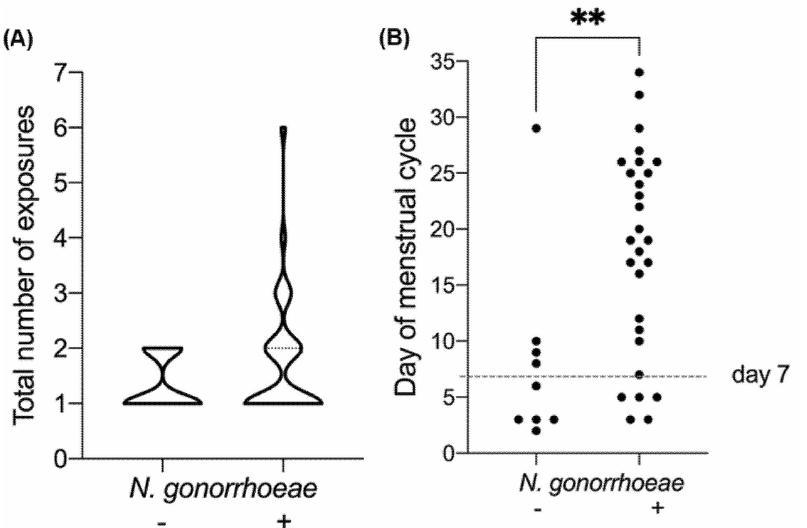
Figure 2. Neisseria gonorrhoeae infection in women exposed to men with gonococcal urethritis. Impact of ( A ) number of exposures and ( B ) menstrual cycle in N. gonorrhoeae culture-negative women ( N. gonorrhoeae -) and culture positive ( N. gonorrhoeae +) women. Infection was associated with a high number of total exposures (>2 and up to 6) ( A ). Uninfected women were mostly exposed during the follicular phase (1–11 days). The most recent exposure for each woman is indicated in ( B ). ** p -value 0.0065